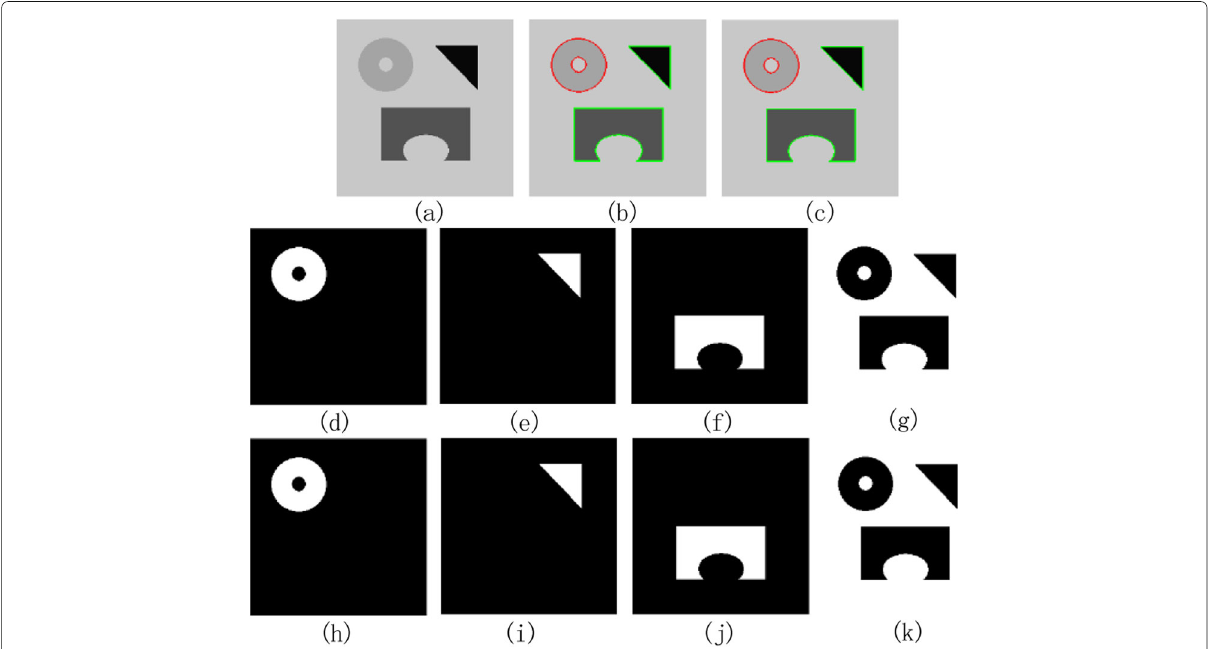
Fig. 2 Comparison of the classic optimization method and ADMM. a The input synthetic image. b The segmentation result of classic optimization method. c The segmentation result of ADMM. d – g Different regions obtained via the classic optimization method. h – k Different regions obtained via ADMM